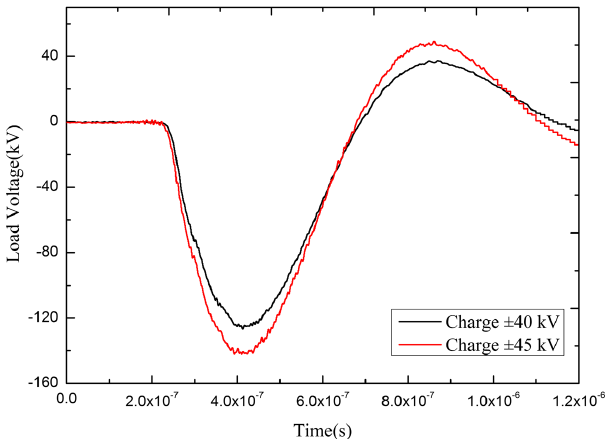
20. Load output voltage waveforms of the hybrid mode LTD